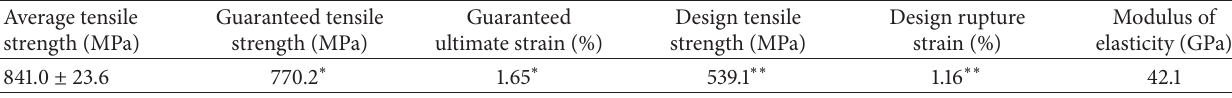
Table 1: Mechanical properties of the GFRP bar used in this study.